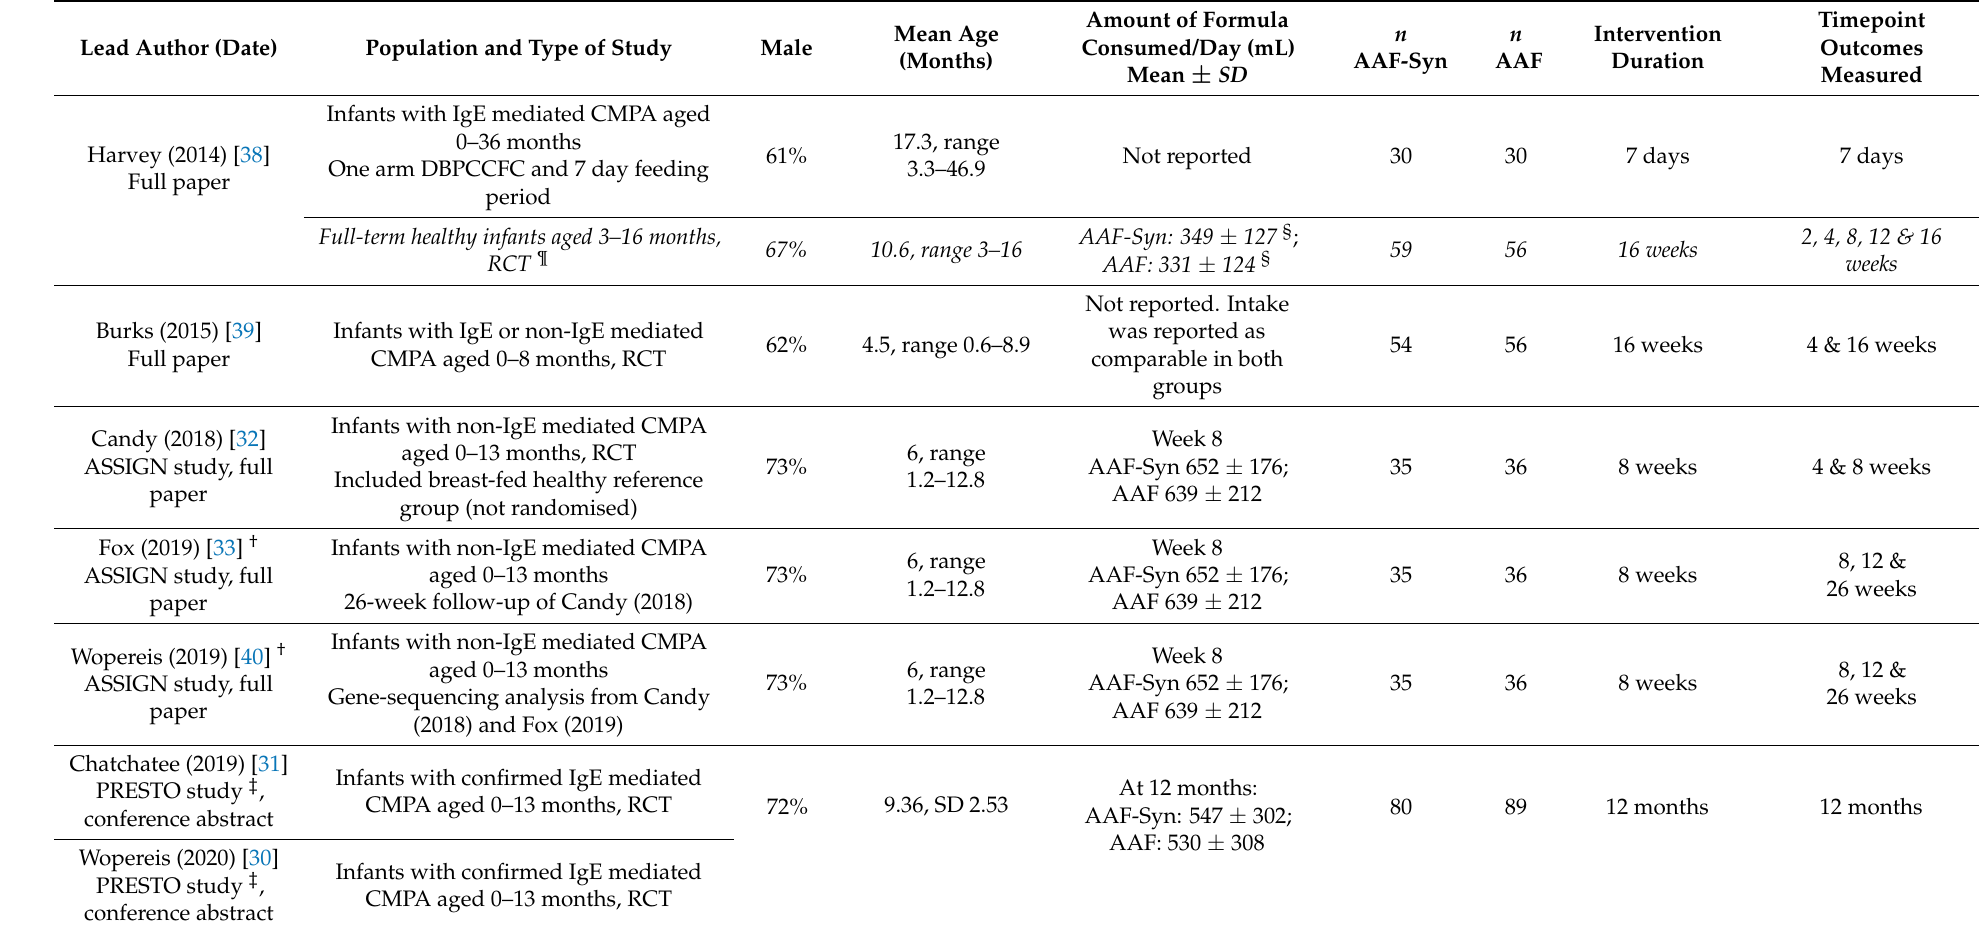
Table 1. Summary of included